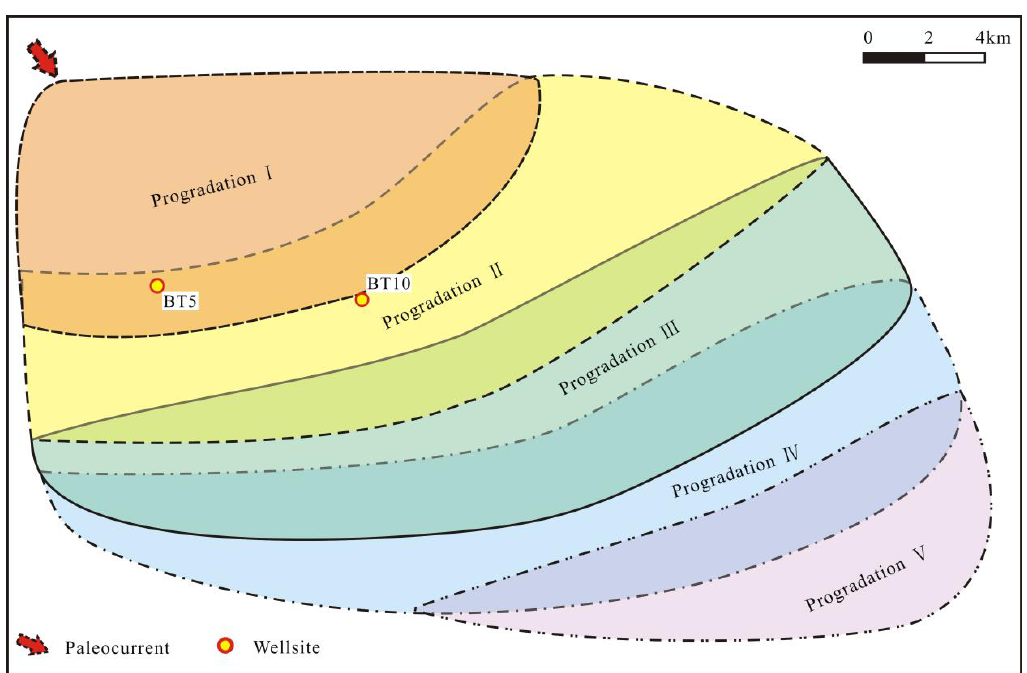
Figure 10. Superposition map five-stage progradational reflections in five different semitransparent colors.